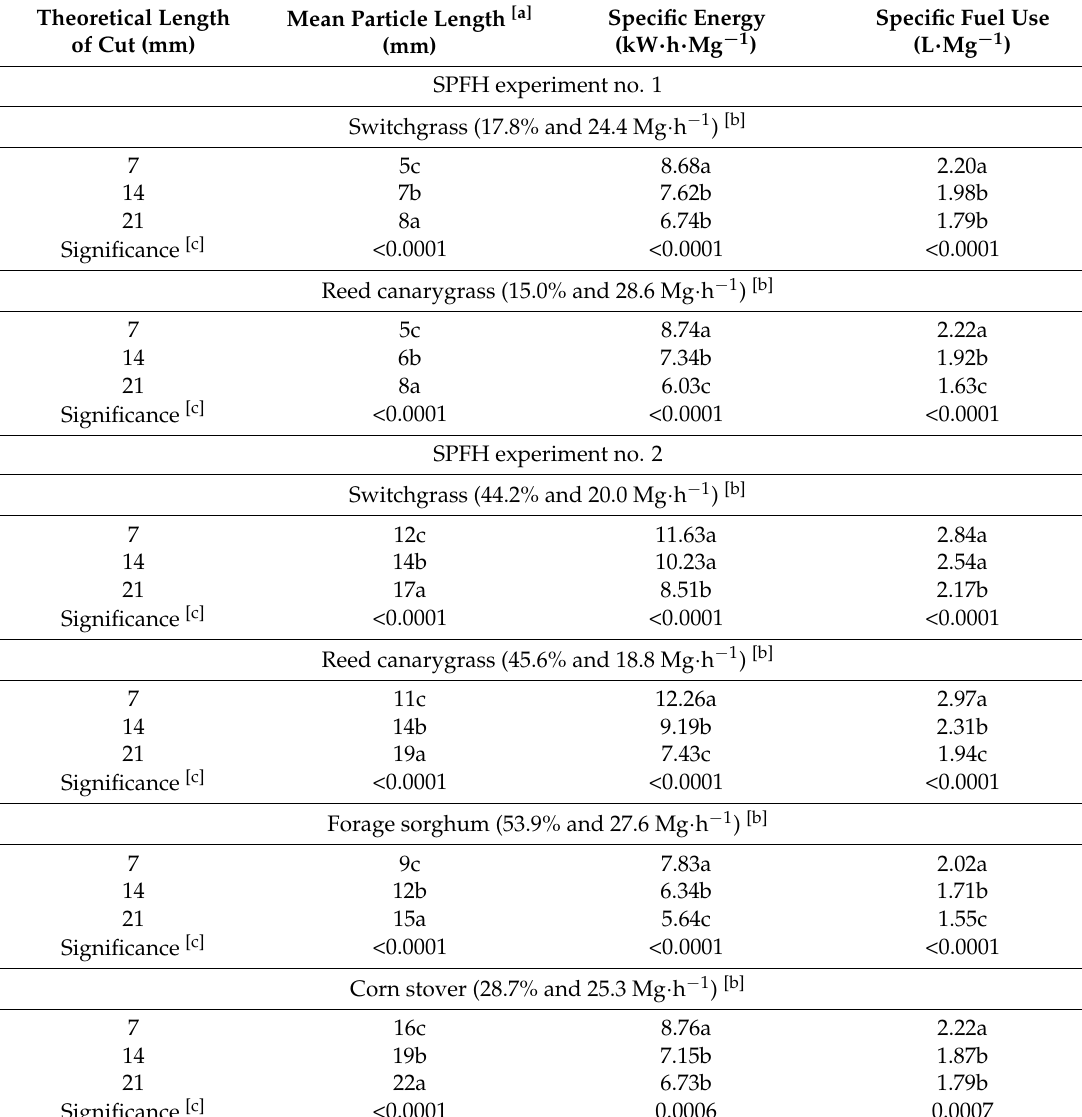
Table 7. Mean particle length and specific energy and fuel use (on a dry basis) when chopping with a self-propelled forage harvester (SPFH) using various theoretical-length-of-cut. Theoretical